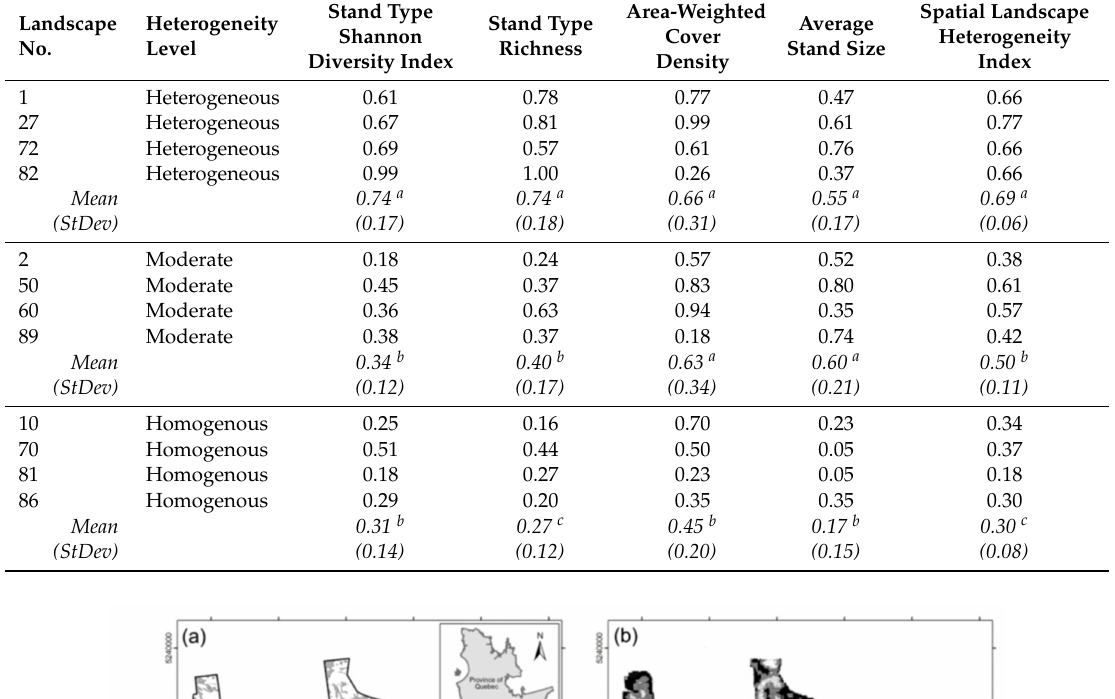
Table 1. Landscape heterogeneity indices of the 12 sampled landscapes. Means with di ff erent letters (column-wise) are significantly di ff erent.